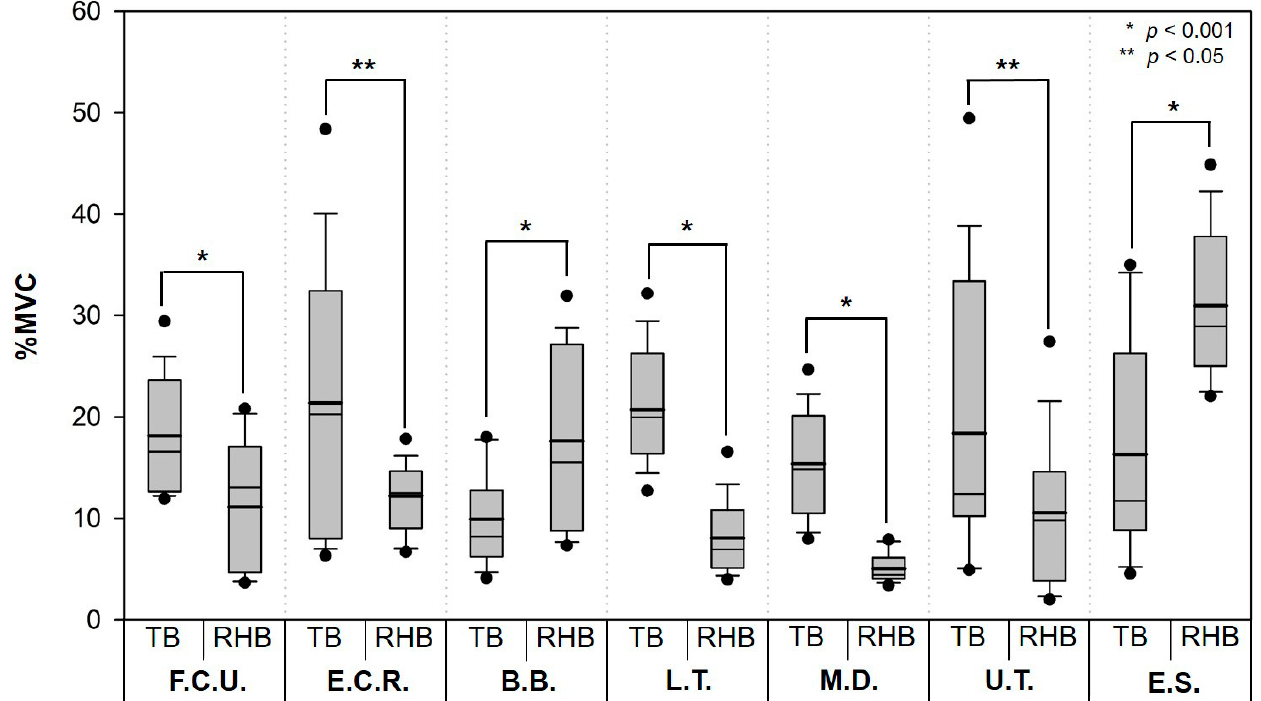
Figure 5. Comparison between the typical harvesting basket (TB) and the harvesting basket with attached the rotational handles (RHB) by seven muscles (bold line, arithmetic mean; circles, 5th/95th percentiles; abbreviations: F.C.U., Flexor Carpi Ulnaris; E.C.R., Extensor Carpi Radialis; B.B., Biceps Brachii; L.T., Lateral Triceps; M.D., Middle Deltoid; U.T., Upper Trapezius; and E.S., Erector Spinae). Table 2. Results of the subjective discomfort levels according to the Borg RPE and Borg CR10 scales. Basket